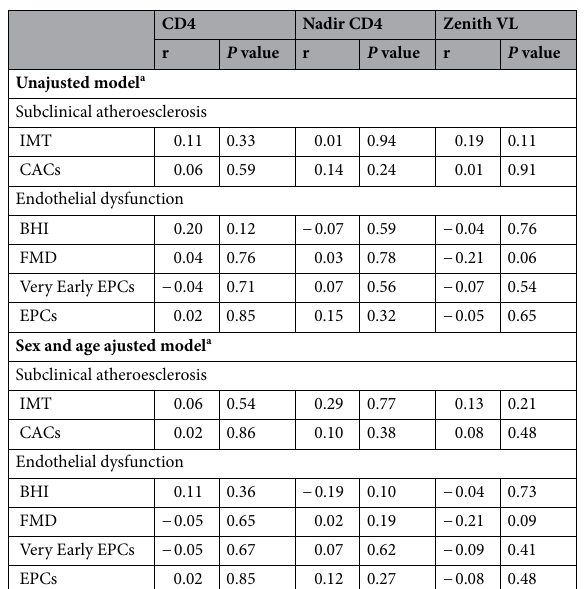
Table 5. Correlation between HIV-related analytical parameters and subclinical atherosclerosis and endothelial dysfunction. Unadjusted model and sex- and age-adjusted model. VL viral load, IMT intima media thickness, CACs coronary artery calcium score, BHI breath holding index, FMD flow mediated dilation, EPC endothelial progenitor cells. a Multiple linear regression models.